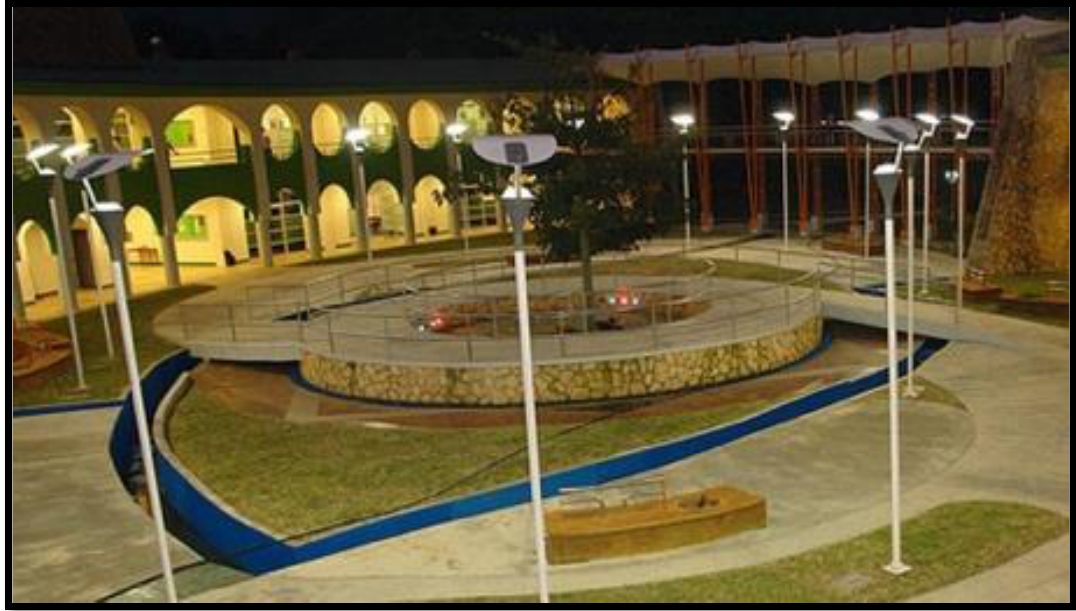
Figure 3, Intercultural University of the State of Tabasco (UIET) Source Architect of the